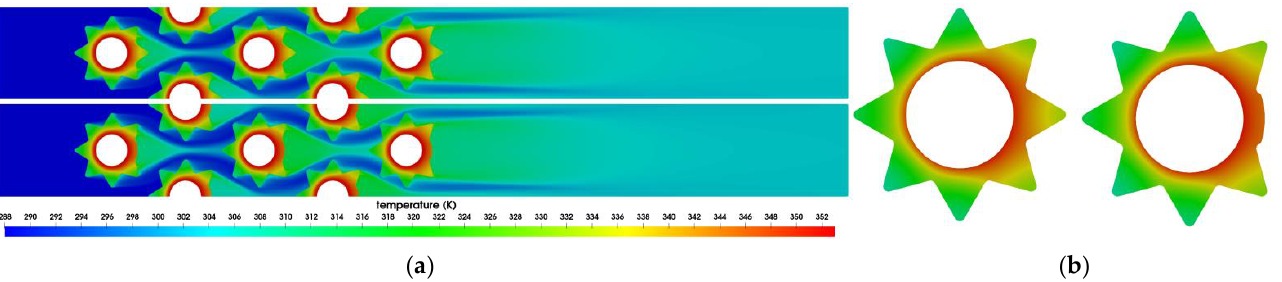
Figure 6. Temperature fields ( a ) for star-shaped fins and trimmed fins; ( b ) fin temperatures in the third row (middle section).